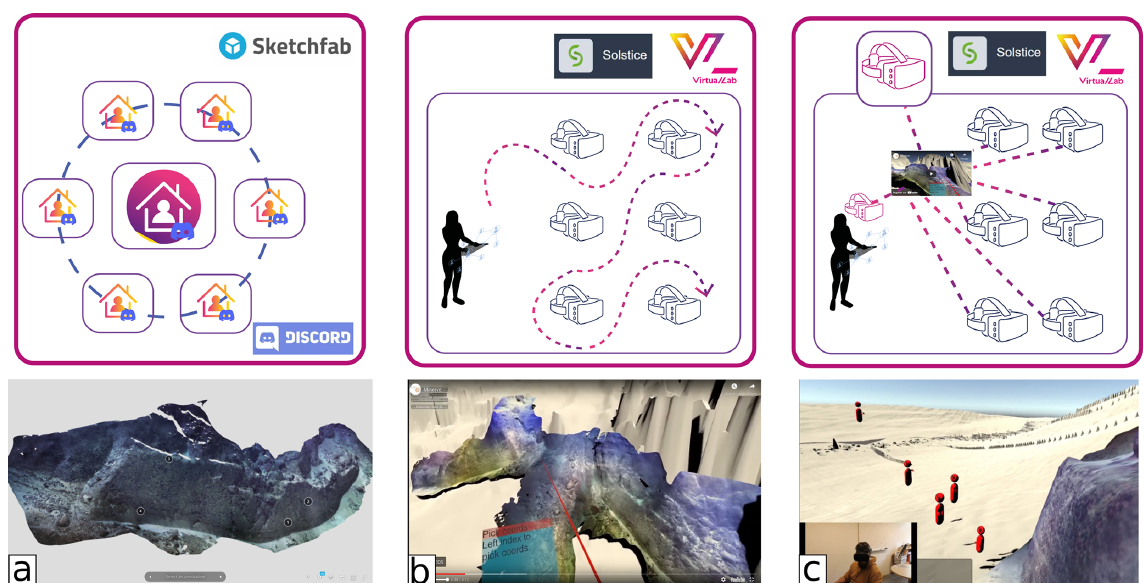
Figure 3. Teaching strategies tested for virtual fieldwork sessions and a view of the studied outcrop. (a) The 100% remote strategy based on the Discord app and the use of a 3D model hosted on the Sketchfab platform. (b) The alone in the field or single-user strategy taking place in the virtual lab with the teacher (dark silhouette) remaining outside the VR environment and guiding the students via the Solstice system. (c) The together in the field or multi-user strategy in the virtual lab with two teachers connected to the VR environment.